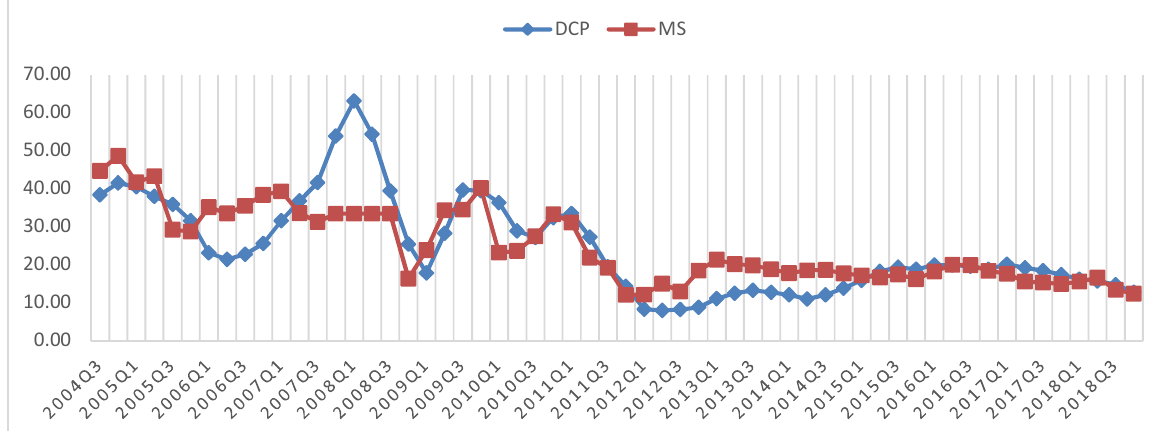
Fig. 2. Growth of the domestic credit to the private sector (DCP) and the money supply (MS) in Vi- etnam (2004: